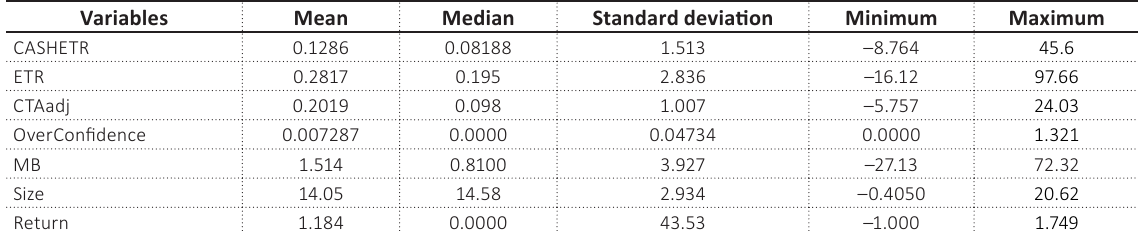
Table 2. Descriptive statistics